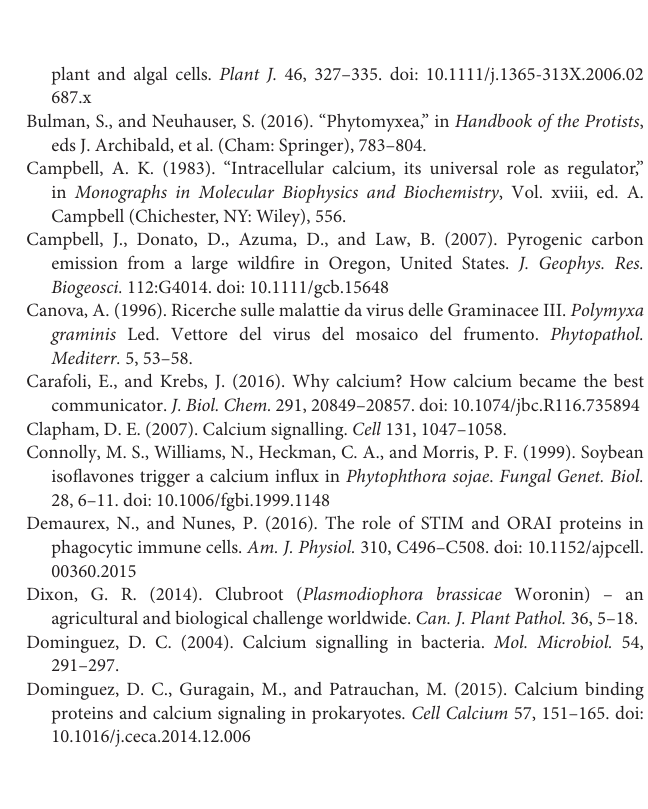
Supplementary Figure 1 | Ca 2 + antagonist anti-chemotaxis microcapillary assay set up. Supplementary Videos 1 | (A–I) Native videos of S. subterranea zoospores 10 min after suspension in deionized water control (A–C) , in 5 µ M